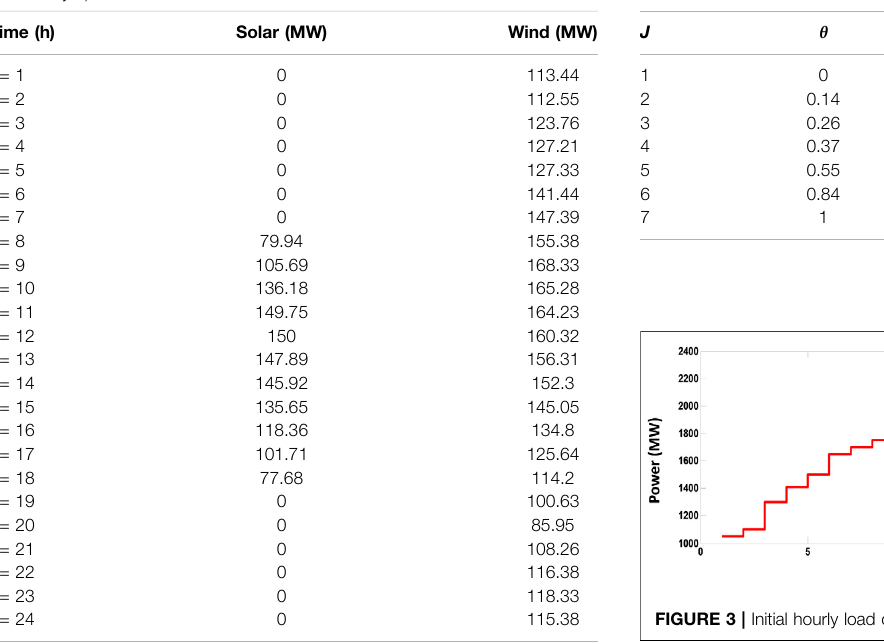
TABLE 7 | Coef fi cients of the customer cost function, customer type, and daily customer curtailment limitations (case study 2) (Scenario-1).